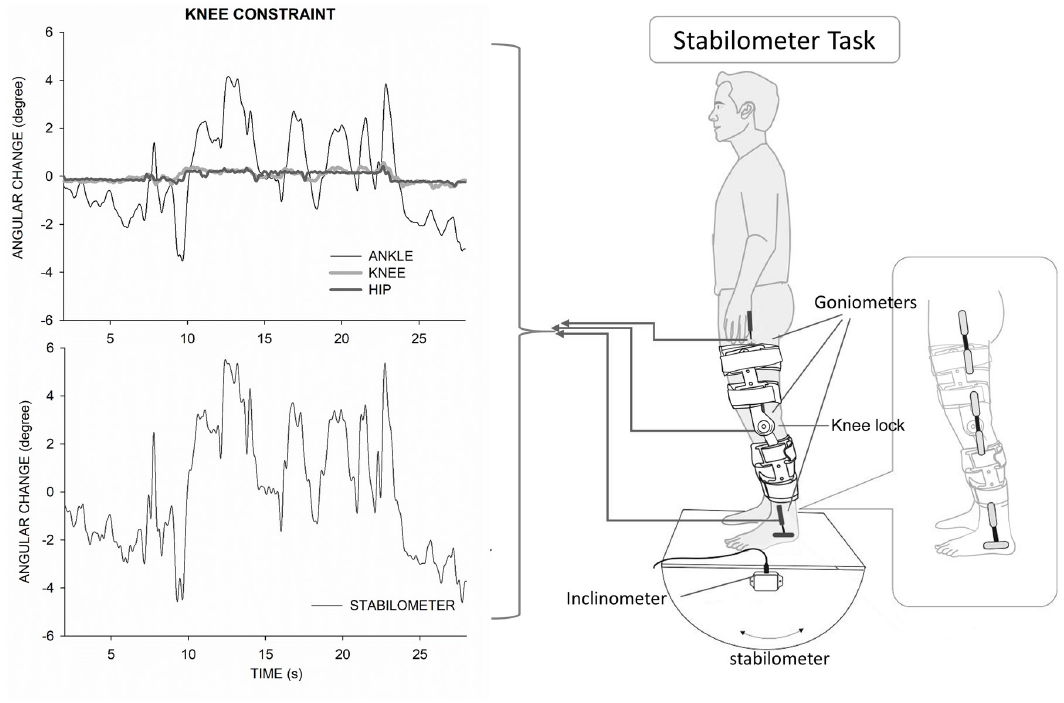
Fig 1. Illustration of the experimental setup and angular excursions in one typical trial in the knee-constraint condition. Illustration of the experimental setup (right plot). Illustration of individual joint angular excursions in one example trial (top left plot). Illustration of stabilometer fluctuation in a typical trial (bottom left